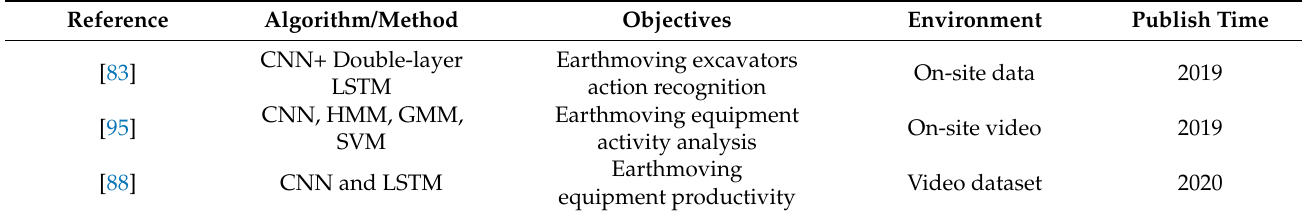
Table 5. CPS on a construction site.